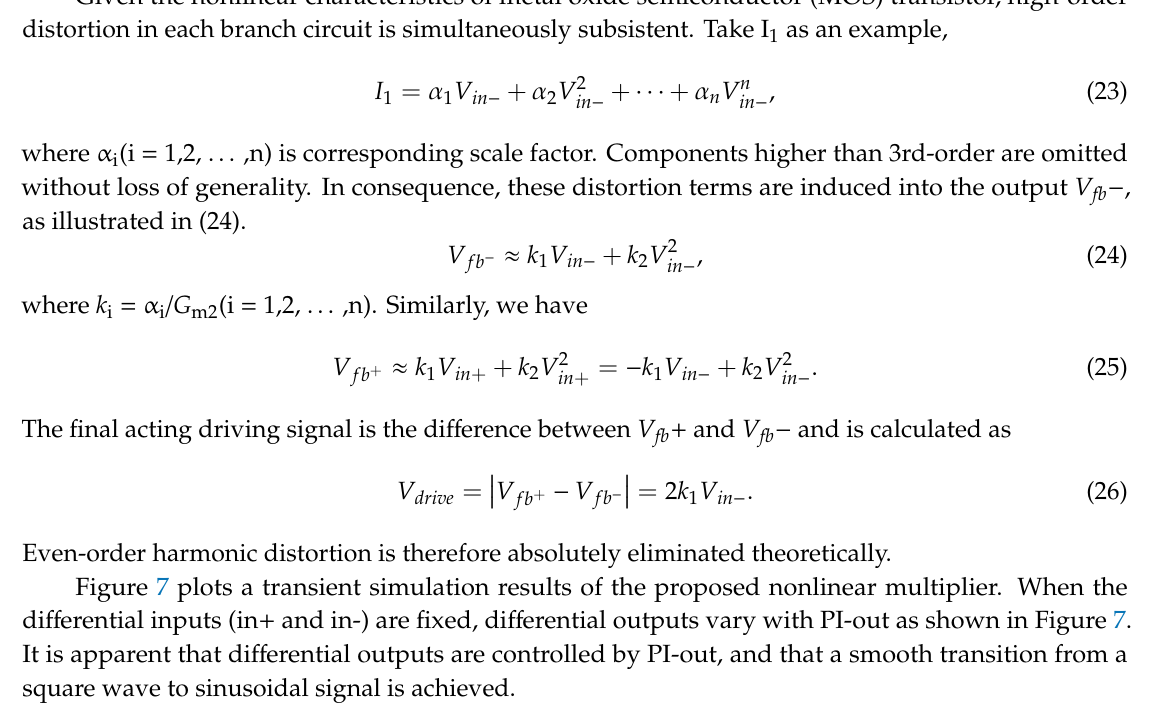
1.035 Figure 8. Linear fitting of multiplier simulation results.